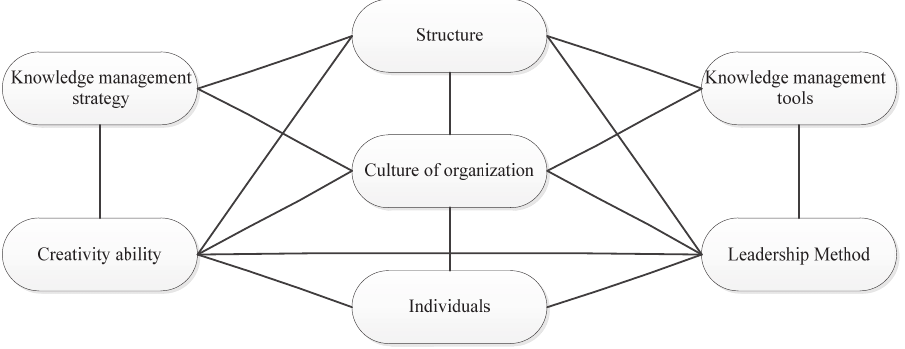
Fig. 1. Success Factors for Knowledge Management (Forcadell & Guadamillas,